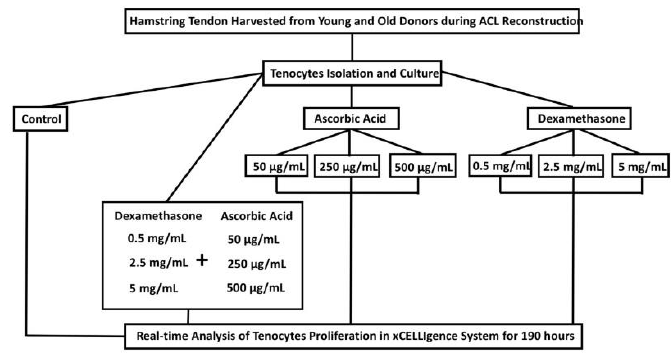
Figure 2. Flowchart of the study.